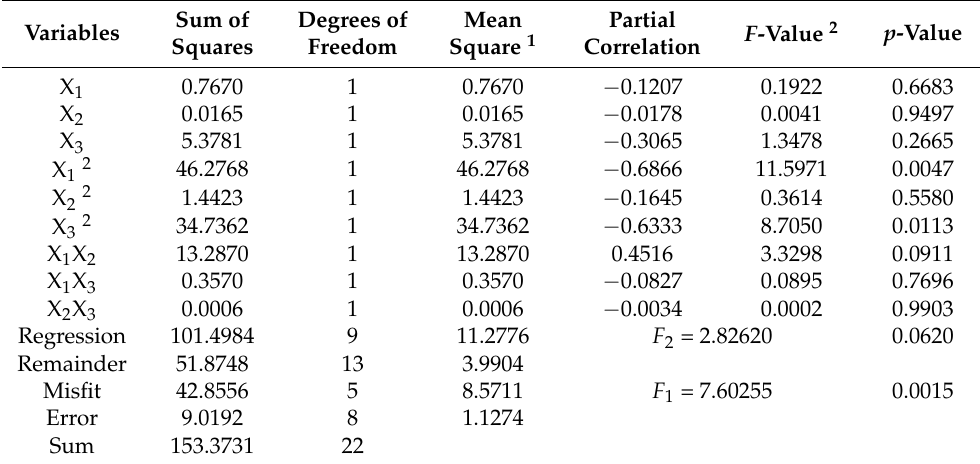
Table 6. Analysis of variance of a regression model based on reducing sugars (y 1 ).